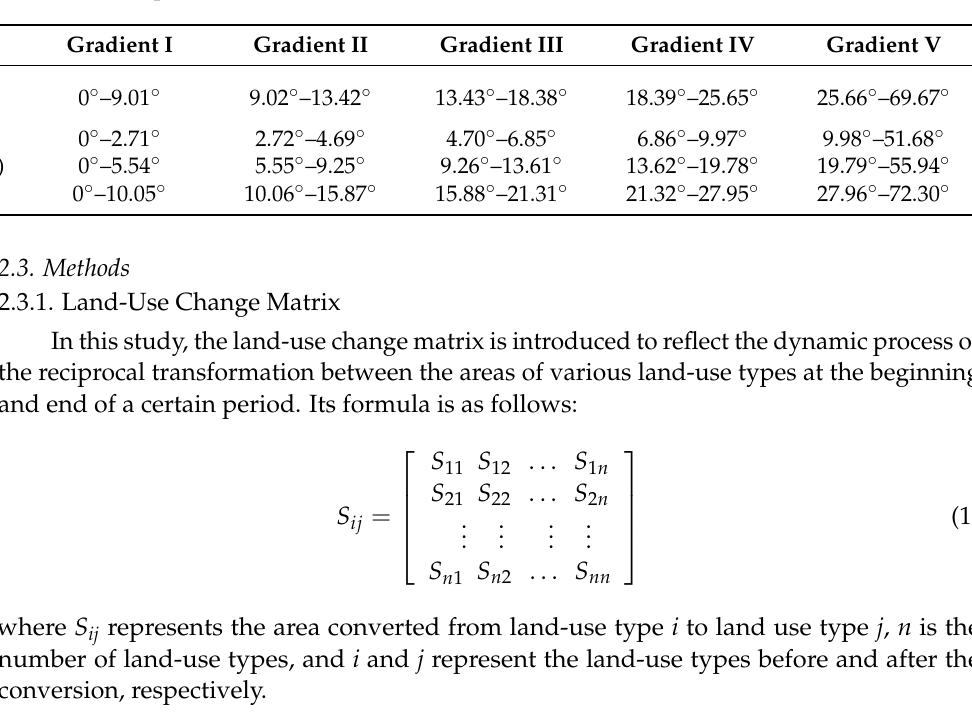
Table 1. The slope classification of the karst mountainous